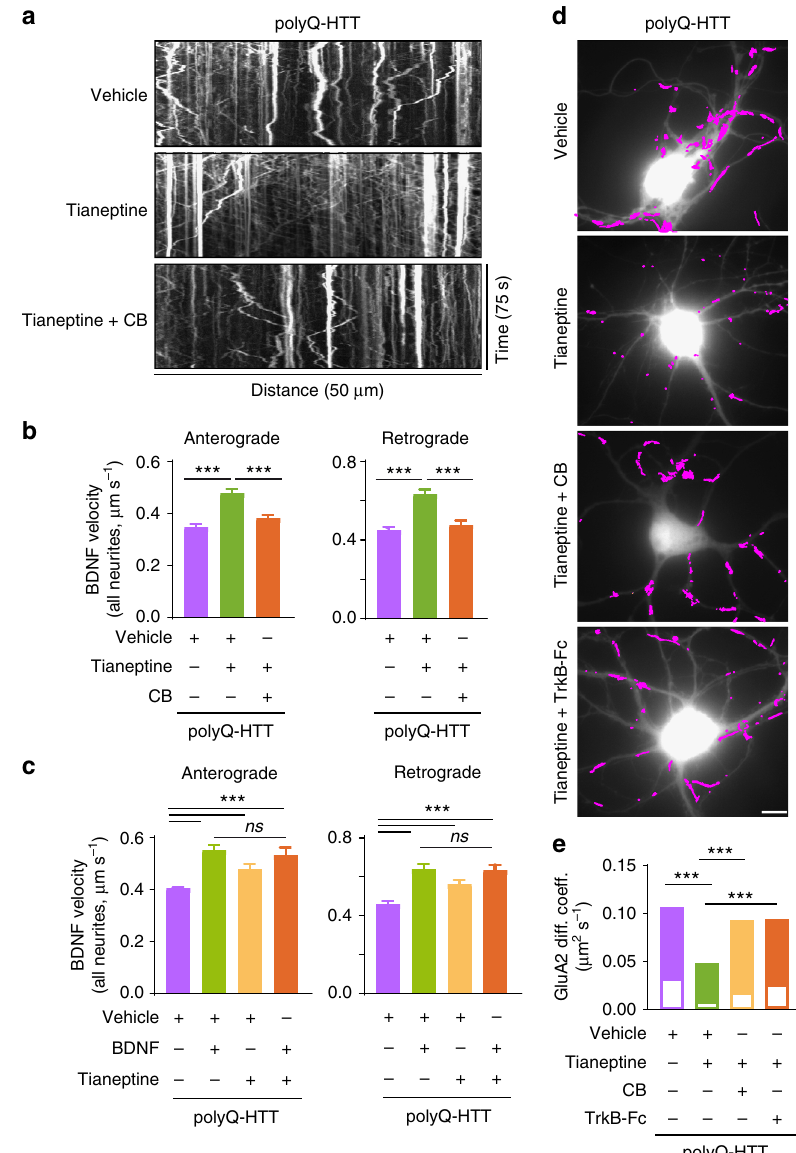
Fig. 5 Tianeptine ’ s effect on BDNF intracellular transport and AMPAR surface diffusion is mediated by BDNF-TrkB signaling pathway. a Representative kymographs of intracellular transport of BDNF-containing vesicles (white trajectories) in a neurite (50 μ m from soma) over 75 s in polyQ-HTT-expressing rat hippocampal neurons treated with vehicle, tianeptine (50 μ M), or Cyclotraxin-B (CB) (1 μ M) plus tianeptine (50 μ M). b , c Anterograde and retrograde BDNF transport velocity in all neurites of polyQ-HTT-expressing rat hippocampal neurons treated with vehicle, tianeptine (50 μ M), or CB (1 μ M) plus tianeptine (50 μ M) ( b ) or treated with vehicle, BDNF (100 ng ml − 1 ), tianeptine (10 μ M), or BDNF (100 ng ml − 1 ) plus tianeptine (10 μ M) ( c ); values are median± 95% c.i. ( b , c ); n = 4322, 4017, 4199, 4354, 3887, and 3954 trajectories for anterograde and retrograde velocity in polyQ-HTT-expressing neurons treated with vehicle, tianeptine, and CB plus tianeptine, respectively ( b ); n = 3505, 3382, 3339, 2099, 3346, 3174, 3190, and 2022 trajectories for anterograde and retrograde velocity in polyQ-HTT-expressing neurons treated with vehicle, BDNF, tianeptine, and BDNF plus tianeptine, respectively ( c ). d Typical GluA2-QD trajectories (magenta) in polyQ-HTT-expressing rat hippocampal neurons, treated with vehicle, tianeptine (50 μ M), CB (1 μ M) plus tianeptine (50 μ M), or TrkB-Fc (1 μ g ml − 1 ) plus tianeptine (50 μ M). Scale bar, 10 μ m. e GluA2-AMPAR diffusion coef fi cients in FL-polyQ-HTT-expressing rat hippocampal neurons treated with vehicle, tianeptine (50 μ M), CB (1 μ M), plus tianeptine (50 μ M), or TrkB-Fc (1 μ g ml − 1 ) plus tianeptine (50 μ M); data are shown as median ± 25 – 75% IQR; n = 601, 535, 708, and 556 trajectories for 4 groups, respectively. Data are representative of a minimum of